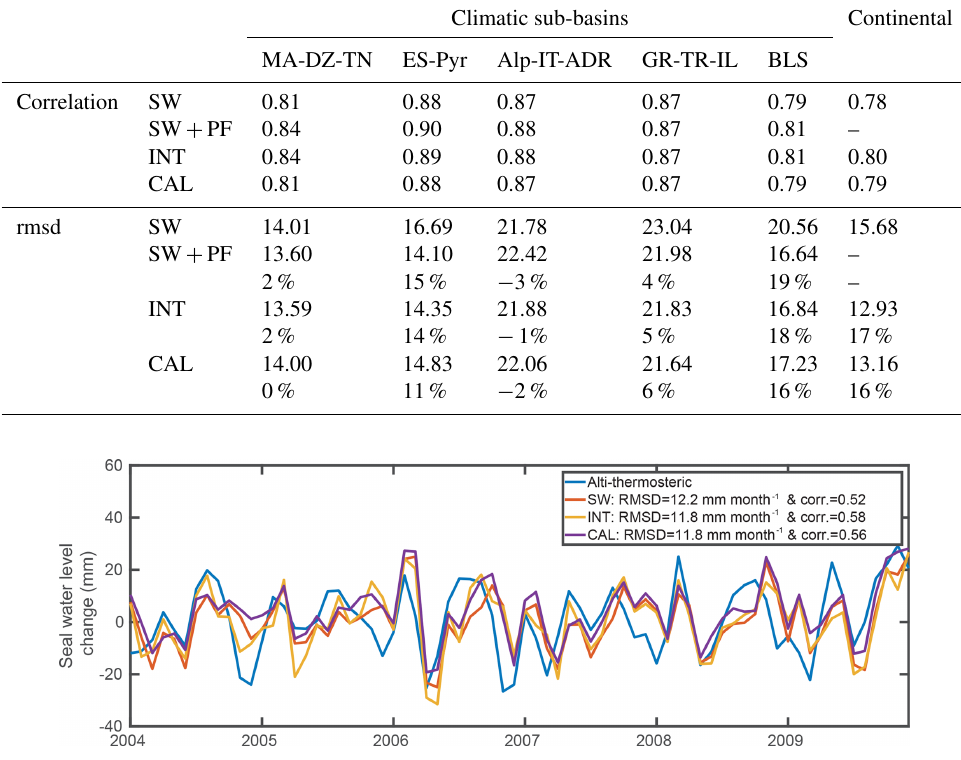
Figure 3. Seawater-level evaluation of SW, INT and CAL estimates compared to altimetry minus thermal content. The correlation difference is statistically significant at the 70% level based on the T